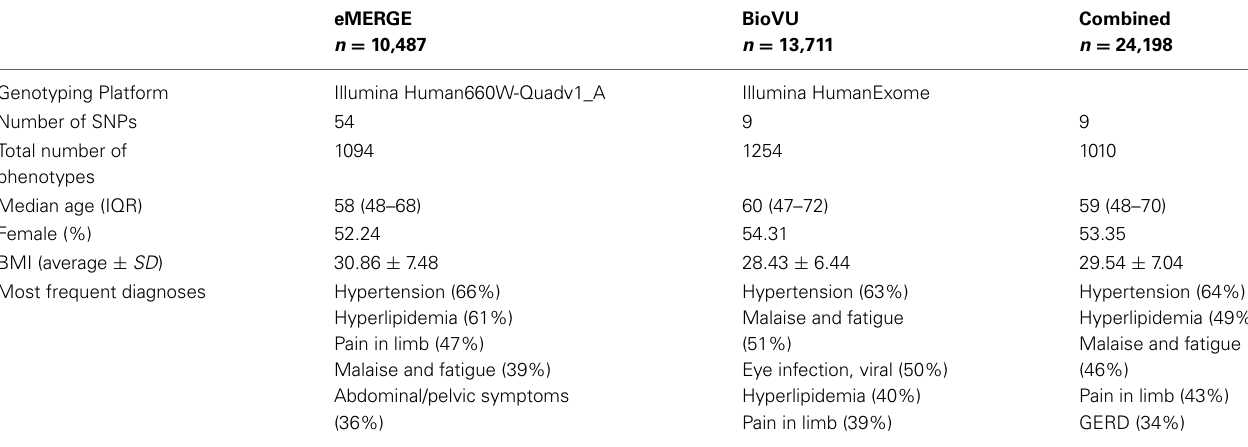
Table 1 | Characteristics of the study